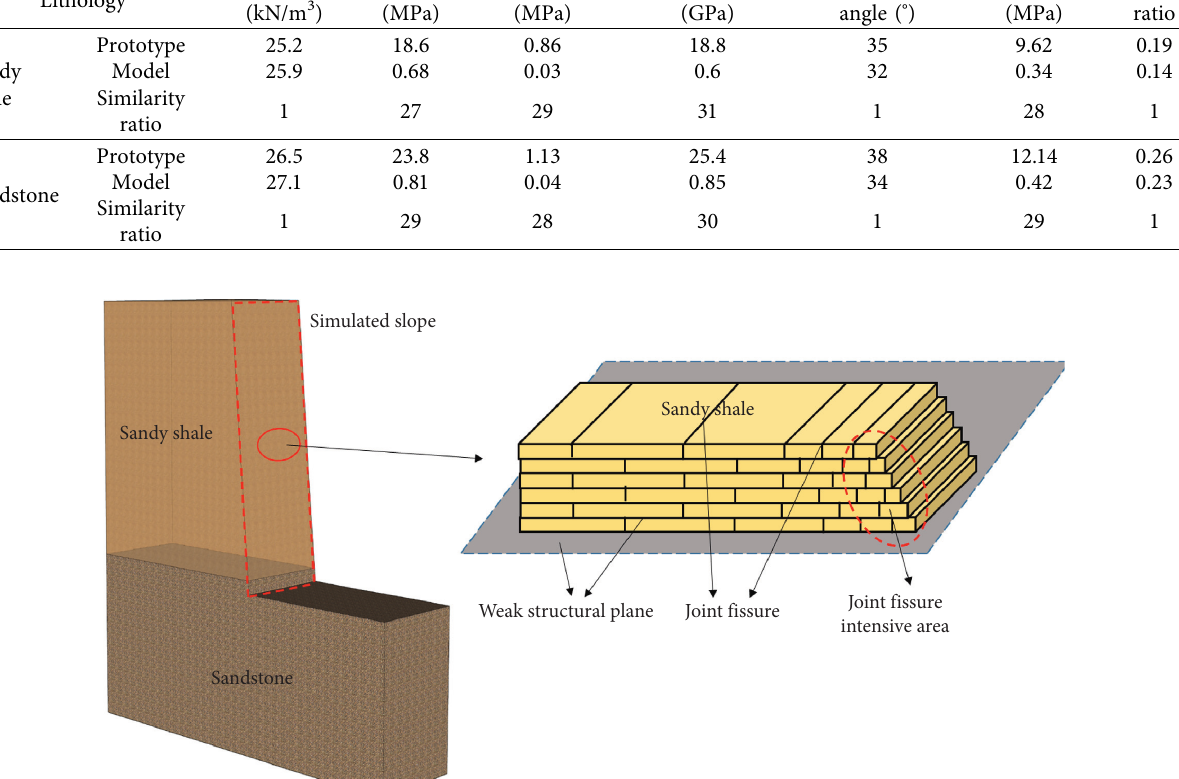
Figure 5: Joint fissure simulation diagram of slope